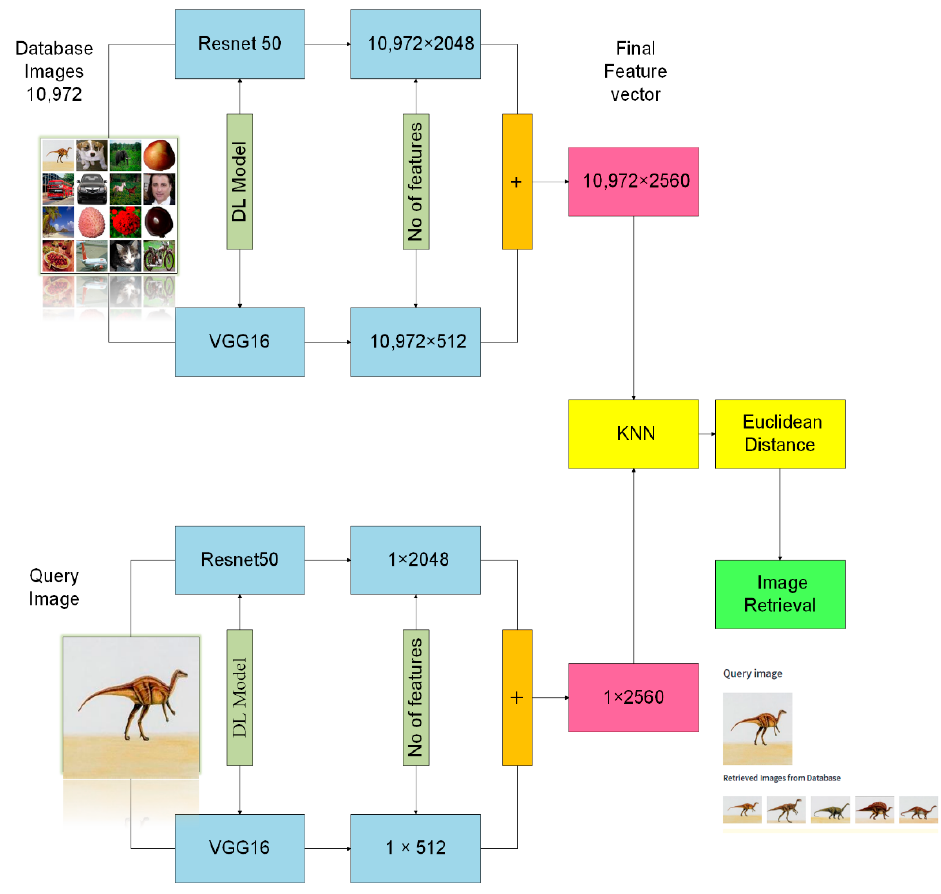
Figure 2. The process of image retrieval.